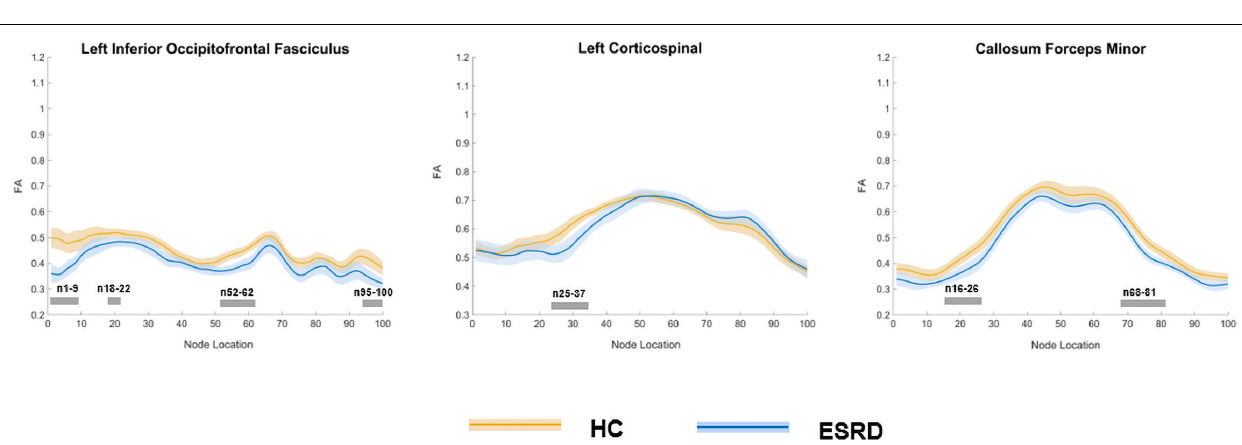
FIGURE 2 | Fibers with statistical differences in mean FA values between HCs and ESRD patients. ∗ P < 0.05, ∗∗ P < 0.01, ∗∗∗ P < 0.001.